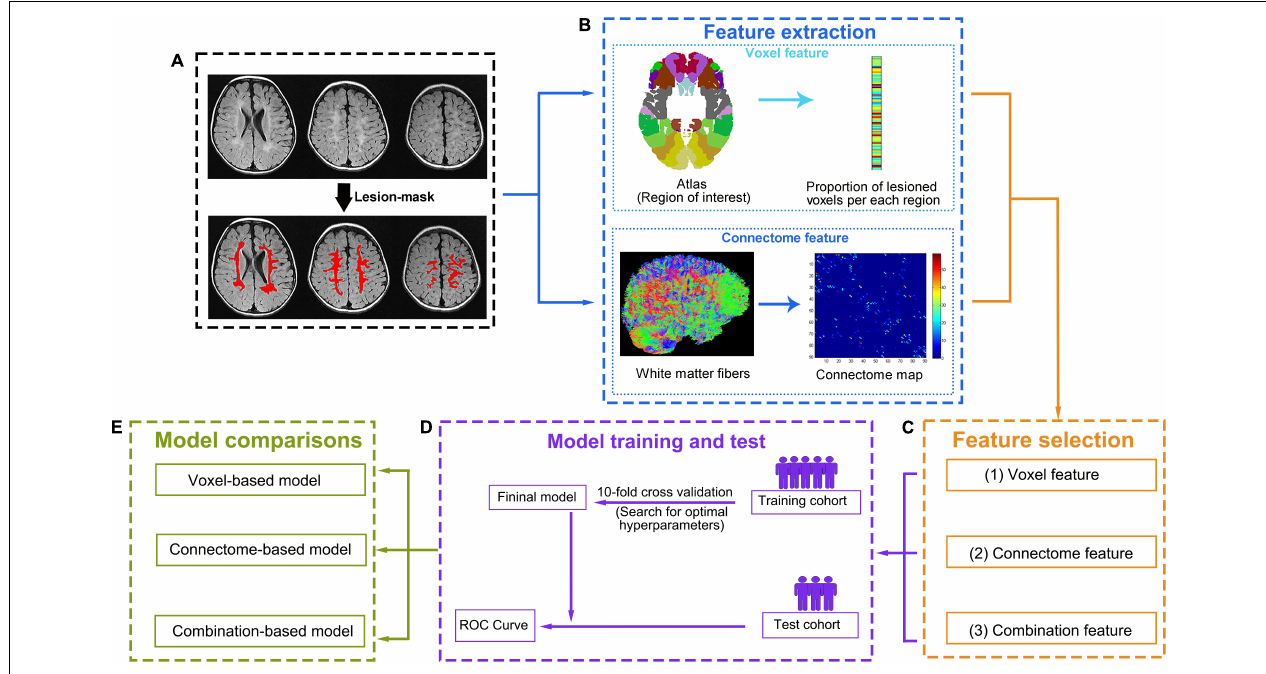
FIGURE 2 | Data processing and analysis workflow. (A) First, the lesion will be manually defined on T 2 -FLAIR images. (B) Two complementary methods, one based on lesions and the other on the connectome, will be used to characterize brain damage. To compute lesion-based damage (top row), the brain atlas and each individual’s lesion mask will be aligned with each individual’s native T 1 space. The gray matter regions will be divided into regions of interest (ROIs) according to the atlas. Then, lesion-based damage will be computed as the proportion of lesioned voxels per ROI based on the lesion mask. Connectome-based damage (bottom row) will be computed as the number of diffusion tensor imaging (DTI) tracts that connect each pair of ROIs (tractography for reconstructing tracts will be performed guided by the white matter probabilistic map). (C) For each individual, three feature sets (lesion features, connectome features, and combination features) will be generated from the corresponding features after feature selection. (D) For each feature set, a “training cohort” will be used to build an optimal model based on a 10-fold cross-validation, and the prediction performance of the optimal model will be tested with the “test cohort” using ROC curve. (E) Then, three optimal models will be generated based on different feature sets (the lesion feature set for voxel model, the connectome feature set for connectome model, and the combination feature set for combination model). The prediction performance of each model will be compared, and the best-performing model will be